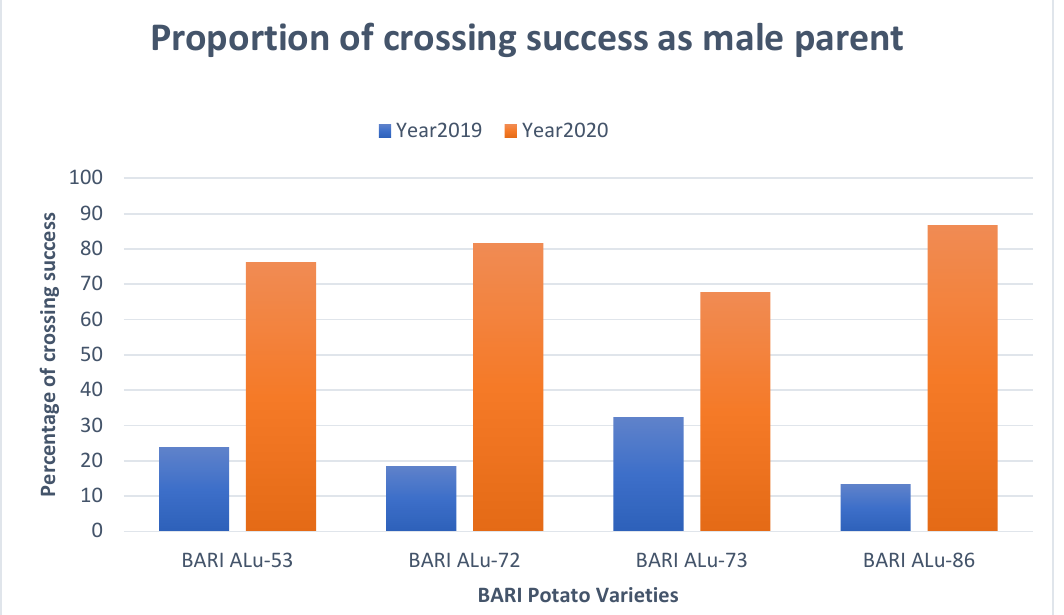
Figure 2. Proportion of successful crosses of each male parent used in potato breeding during 2019 and 2020.